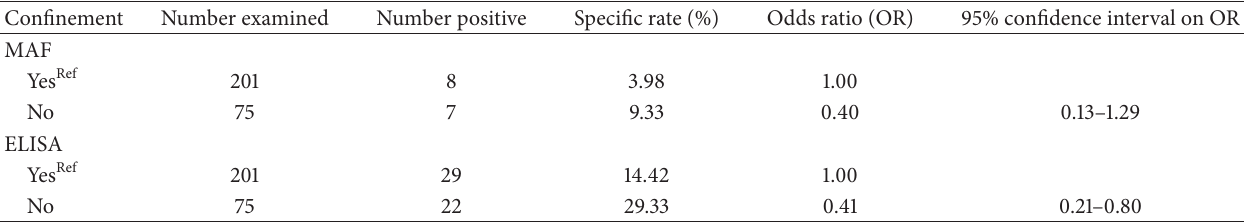
Table 6: Odds ratio and 95% confidence interval on effect of confinement on the prevalence of Cryptosporidium infection in dogs using MAF and ELISA in the FCT, Abuja.